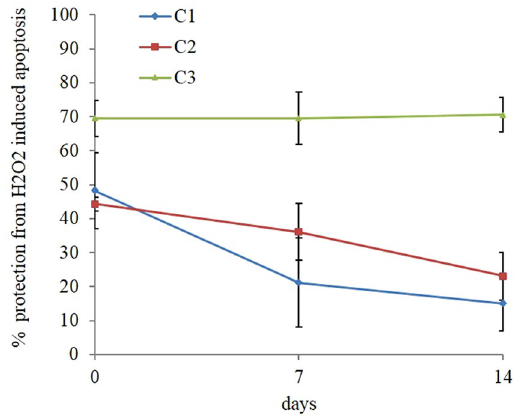
Figure 8. CNP redox activity over time. % protection from apoptosis in cells treated with H 2 O 2 ± C1, C2, and C3 supernatant suspensions after 7 and 14 days. Values are the mean of ≥ 3 independent experiments ±